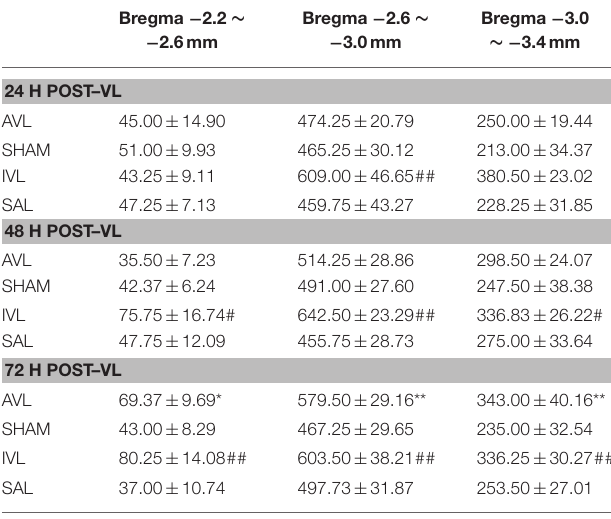
TABLE 2 | Effects of vestibular lesion (VL) on the number of orexin-A-labeled neurons in the